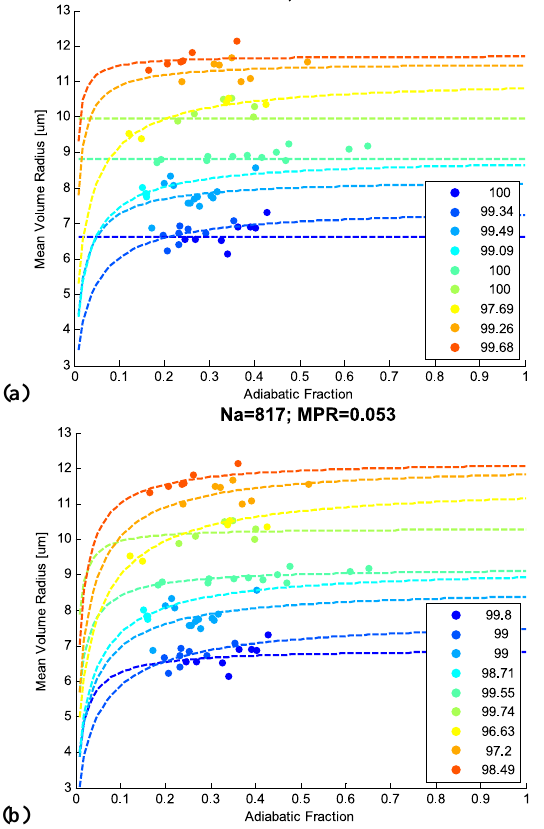
Fig. 3. (a) A mixing diagram for different horizontal cloud passes at various altitudes within the same cloud. Each data point is based on the CDP 1Hz measurement from flight 20090825 (the same as in Fig. 2) and each color denotes the same cloud pass. The dashed lines denote the R v to AF theoretical relations for the de- rived RH best (see text for description) that best fits the data points (with AF > 0.1) for each cloud pass separately. N a , which is used init in the derivation of the RH best values for each penetration (shown in the legend), as well as the mean penetration residual (MPR; see Sect. 3.4) calculated for all fits, are shown at the top of the panel. (b) Same as (a) , but with the final derived N a (see Sect. 3.4) and the minimal MRP that showed best overall fit to the same dataset as in panel (a) . The legend shows that there is a small decrease in the RH best values in this panel. This is due to the higher R v values a here in comparison to (a) .